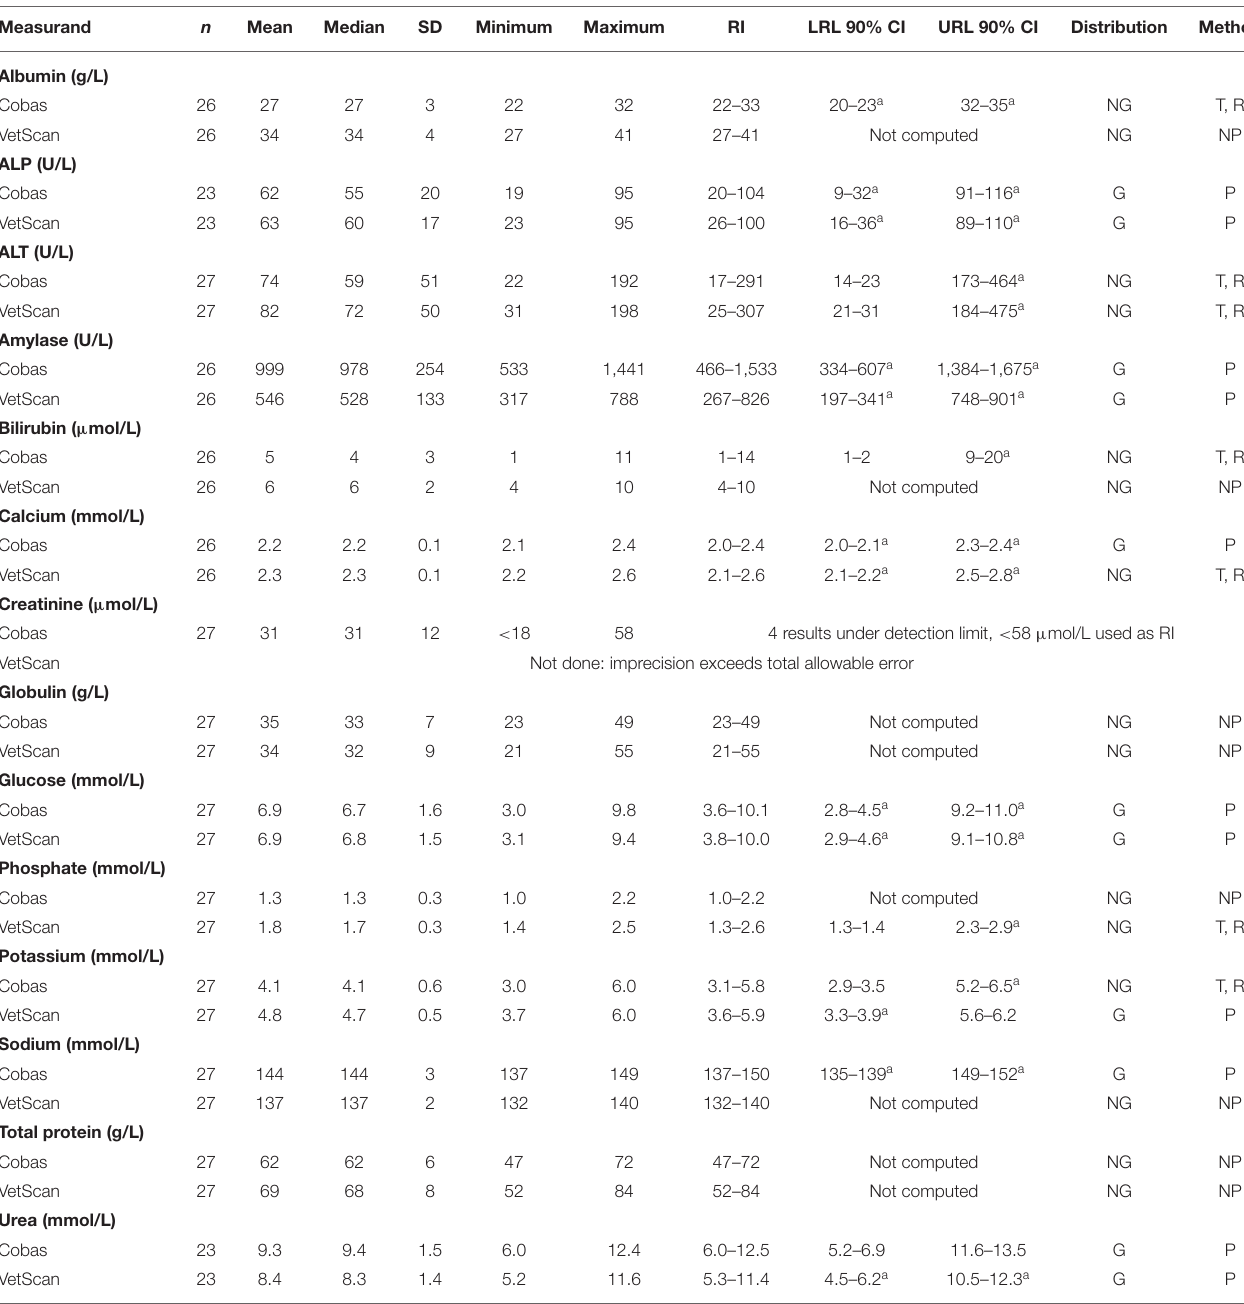
TABLE 4 | Clinical chemistry reference intervals for Temminck’s pangolin measured from heparin plasma on the Abaxis VetScan VS2 and Roche Cobas Integra 400 Plus analyzers.